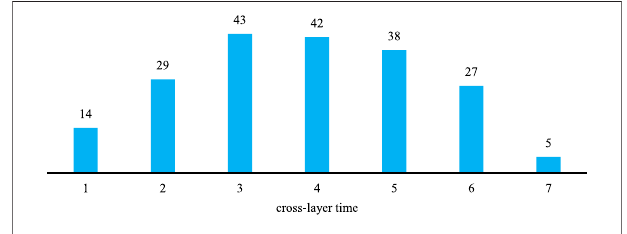
FIGURE 10 | Total times of cross-layers in a range of 200 m of 198 CD stages.